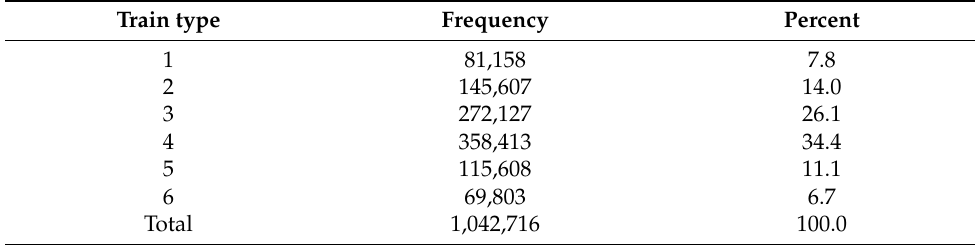
Table 3. Number of trips analysed for each of the included train